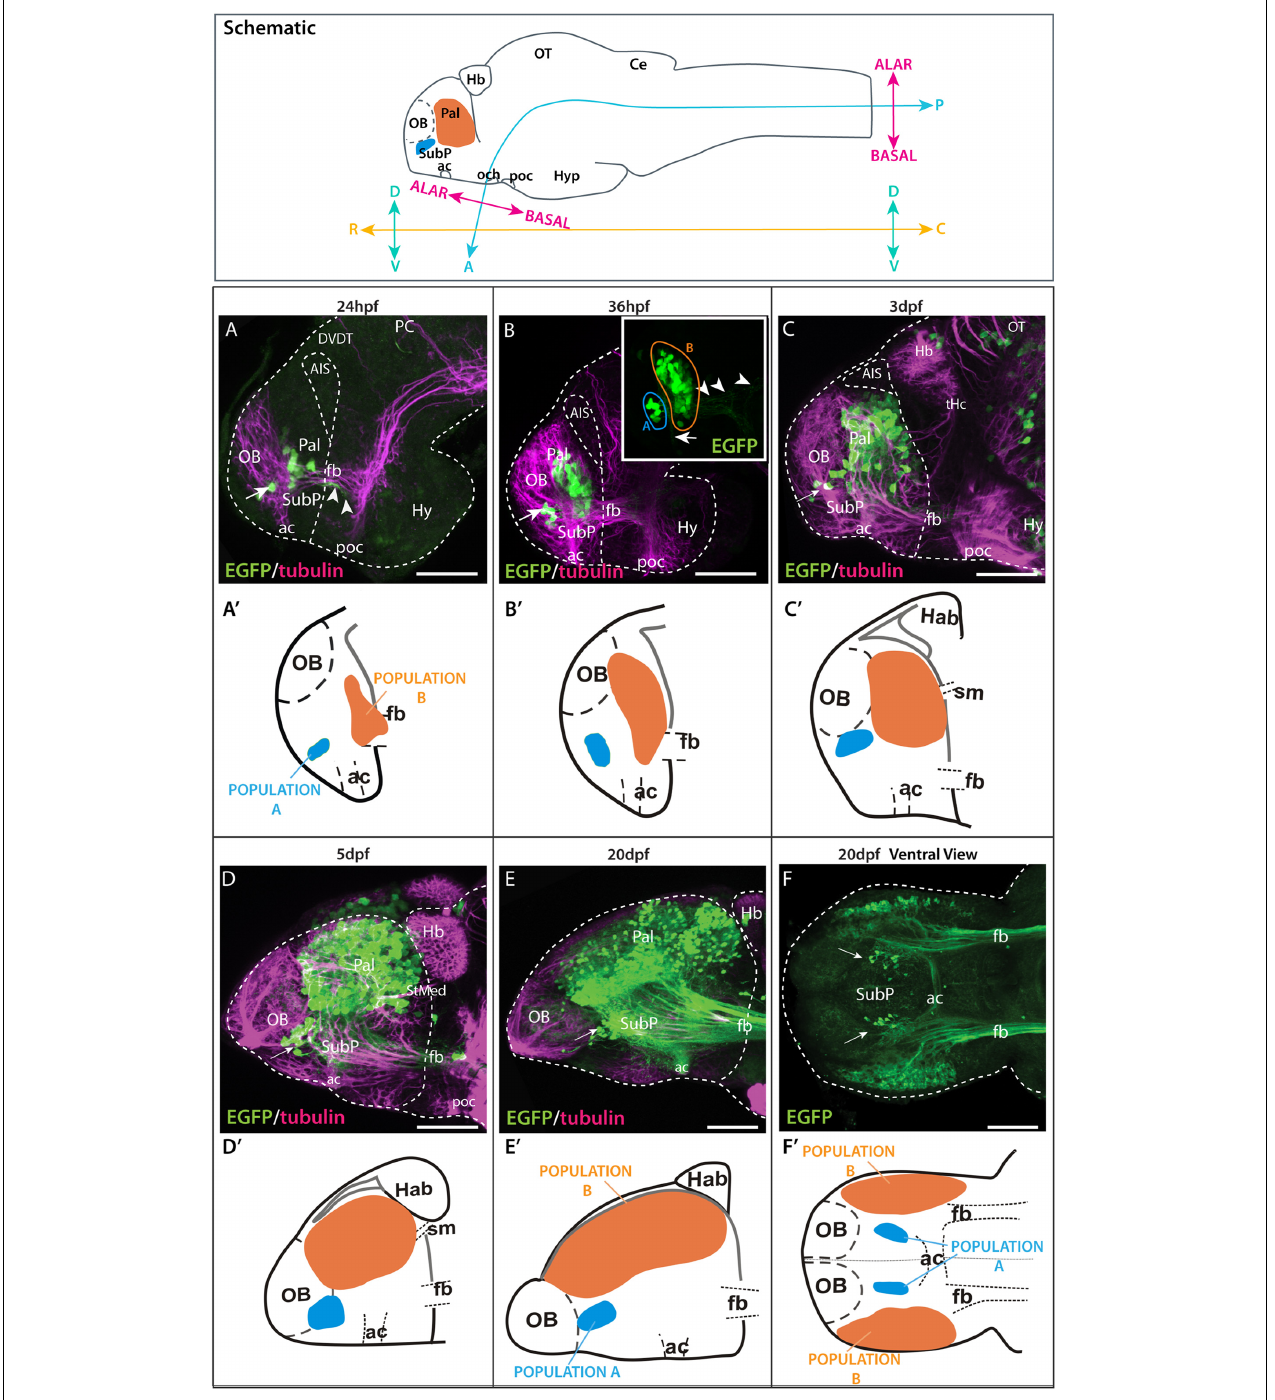
FIGURE 4 | Time series showing Et( gata2:EGFP ) bi105 expression. Top box: sagittal view of a 3dpf zebrafish larval brain illustrating the body axis coordinates (“rostral,” “caudal,” “dorsal,” and “ventral”) predominantly used in this paper (adapted from Herget et al., 2014). For reference, the bent neuraxis of the neural tube is also shown (see Herget et al., 2014) with the alar/basal subdivision of the brain defined according to the neuromeric model (Puelles and Rubenstein, 2003, 2015). Lateral (A–E) and ventral (F) views of zebrafish brains stained against EGFP only inset in (B,F) or EGFP in combination with acetylated tubulin (A–E) from 24 hpf to 20 dpf. Arrow points to the ventral EGFP+ population identified as a subpallial nucleus. Arrowheads in panels [ (A , B) inset] point to processes exiting the telencephalon along the forebrain bundle toward caudal areas. Arrow in panel (B) inset points to processes extending to the dorsal part of the anterior commissure. (A (cid:48) –F (cid:48) ) Schematics showing the changes in location of the EGFP+ populations A and B relative to telencephalic regions and tracts over time. Rostral to the left. Scale bars: (A–D) 50 µ m; (E,F) . Axis coordinates abbreviations: A, anterior; C, caudal; D, dorsal; P, posterior; R, rostral; V, ventral. 100 µ